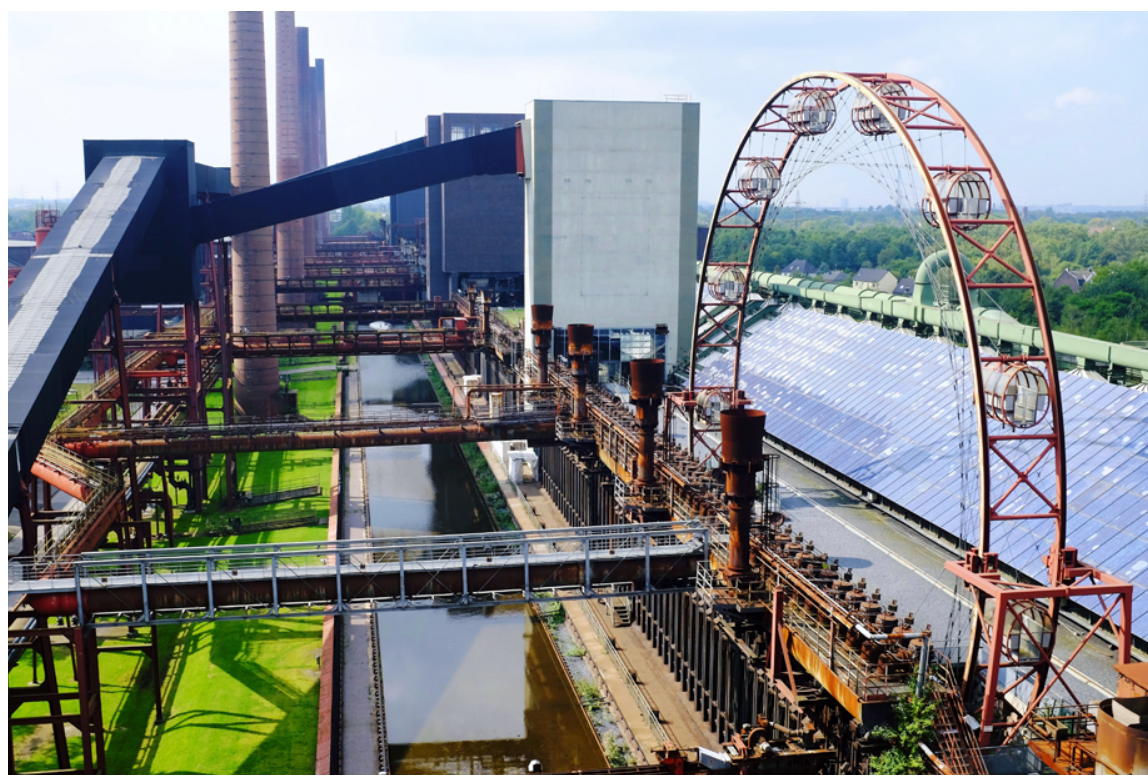
Zollverein park. Photo Wikimedia Commons FIG.